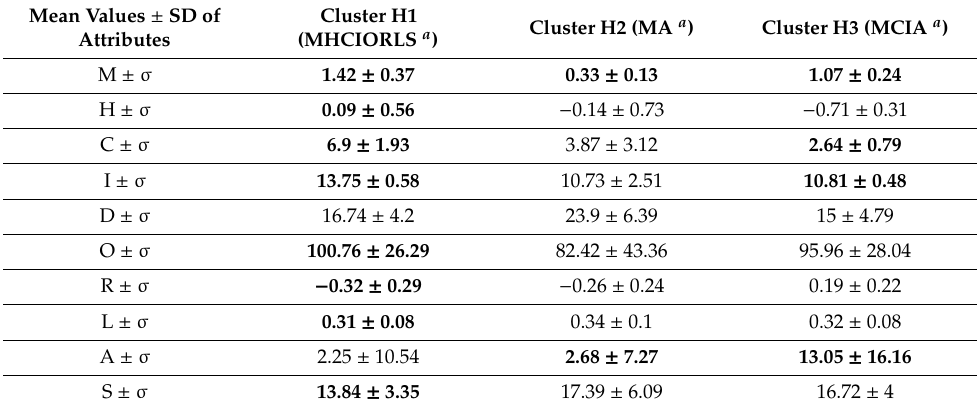
Table 1. Average values and standard deviation of 9 physico-chemical characteristics for optimized clusters for 10-16 aa long peptides non-active against Human erythrocytes.